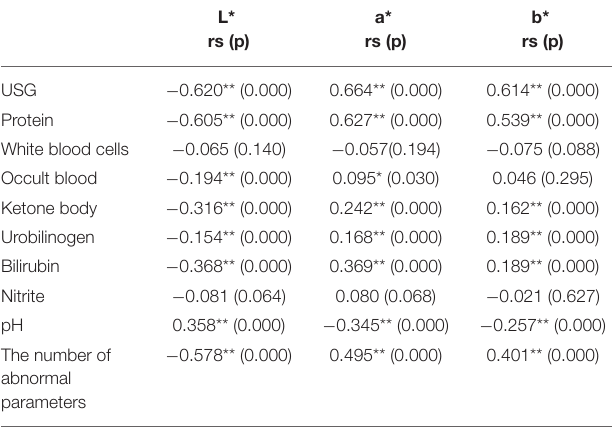
TABLE 5 | Spearman correlation analysis results of urine color space values and urine dry chemical